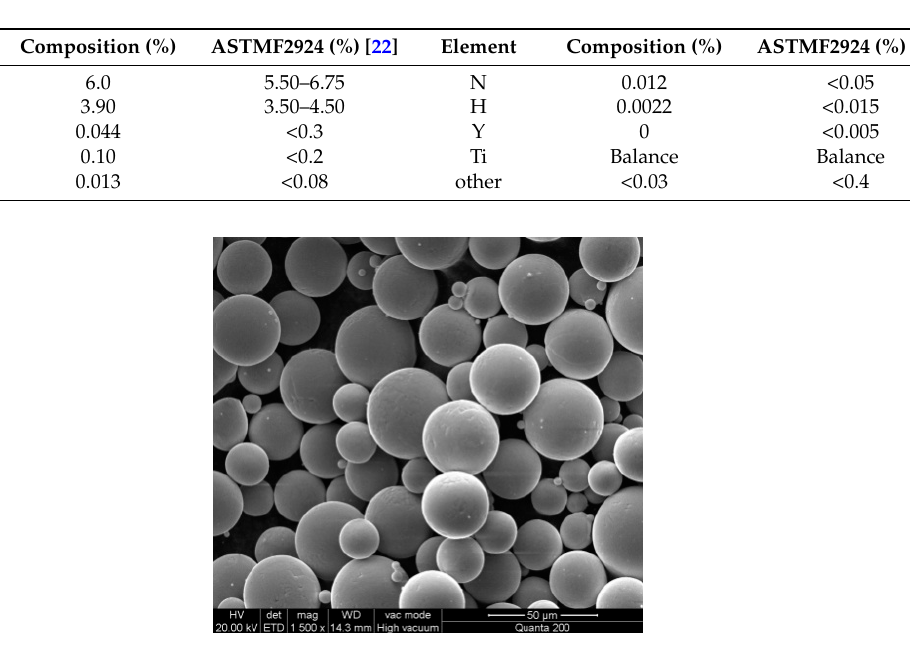
Table 1. Comparison between compositions of SLM fabricating powder and standard powder (part of the composition data obtained from reference [22]).